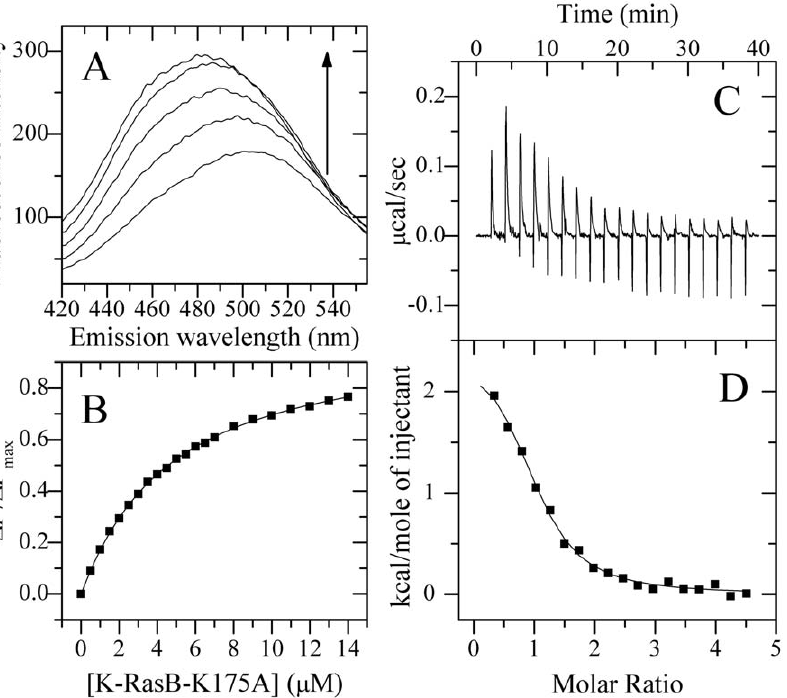
Figure 3. Interaction of K-RasB-K175A with Ca 2 + /CaM at 25.0 6 C. Fluorescence spectra (A) of 1.0 m M dansyl-CaM in the absence and in the presence of K-RasB-K175A-GppNHp at different concentrations. The arrow represents the concentration of K-RasB-K175A increases gradually from 0 (the bottom) to 14.0 m M (the top). D F / D F max for the binding of K-RasB-K175A to Ca 2 + /CaM plotted as a function of the concentration of K-RasB-K175A (B). The solid squares were the experimental data and the solid line represented the best fit. The panel C represents typical calorimetric titration of K- RasB-K175A (35.0 m M) with CaM (800 m M) in the presence of 1 mM CaCl 2 . The panel D shows the plots of the heat evolved (kcal) per mole of CaM added, corrected for the heat of CaM, against the molar ratio of CaM to K-RasB-K175A. The data (solid squares) were fitted to a single set of